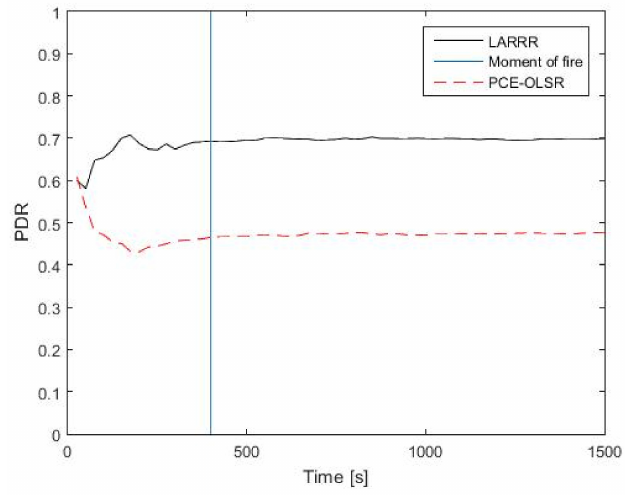
Figure 11. PDR results between LARRR and